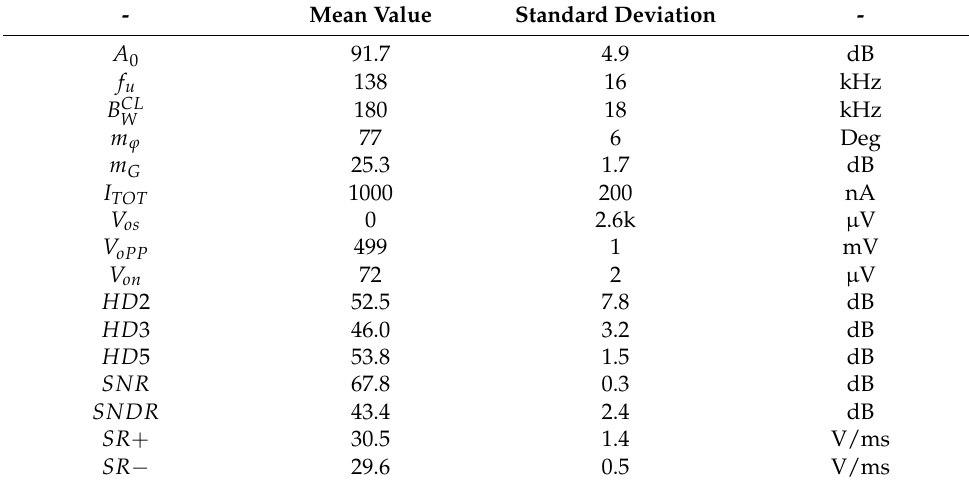
Table 6. Monte Carlo simulation results (mismatch